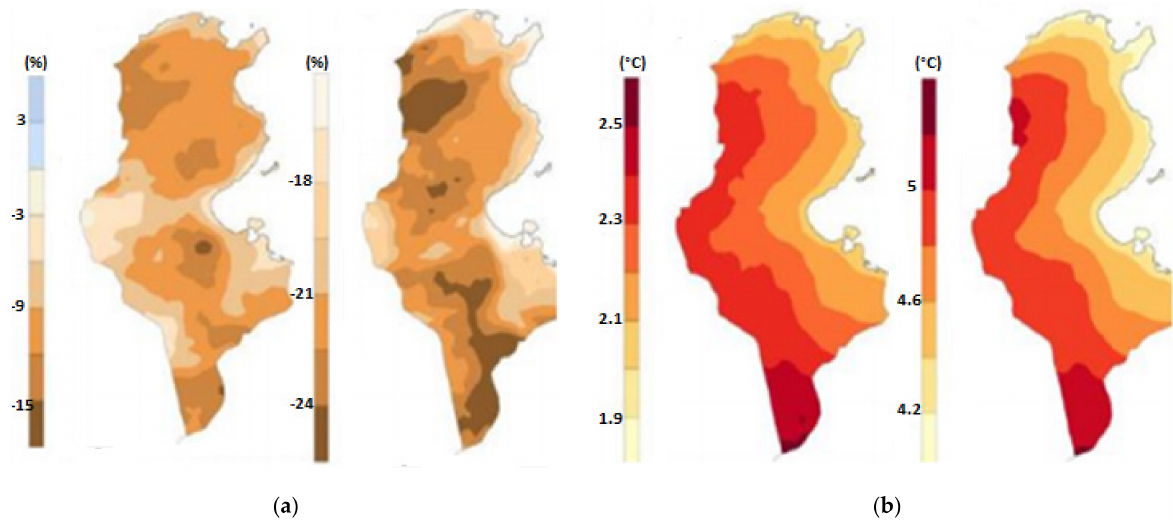
Figure 2. Climate projections in Tunisia for 2050 and 2100: ( a ) climate projections of precipitation; ( b ) climate projections of air